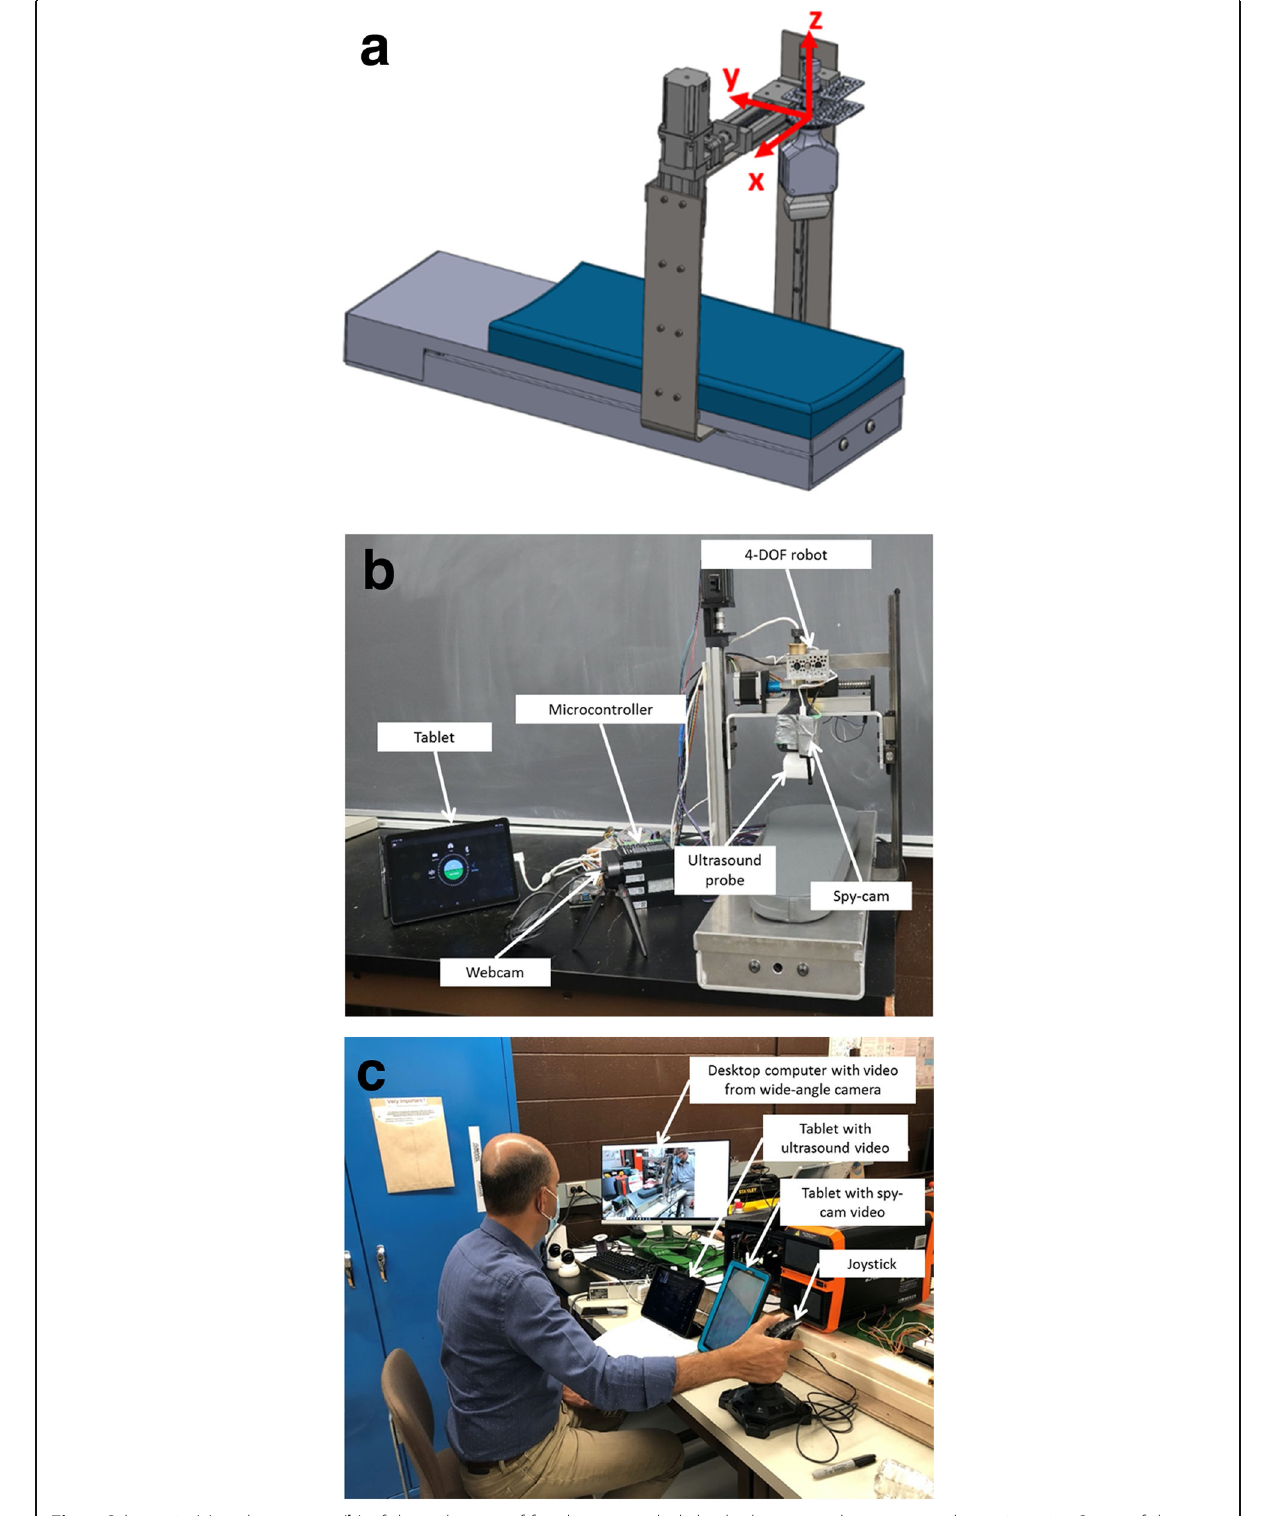
Fig. 1 Schematic ( a ) and prototype ( b ) of the 4-degrees-of-freedom musculoskeletal telesonography system at the patient site. Setup of the system at the master site ( c ), with the radiologist controlling movements of the ultrasound probe via a